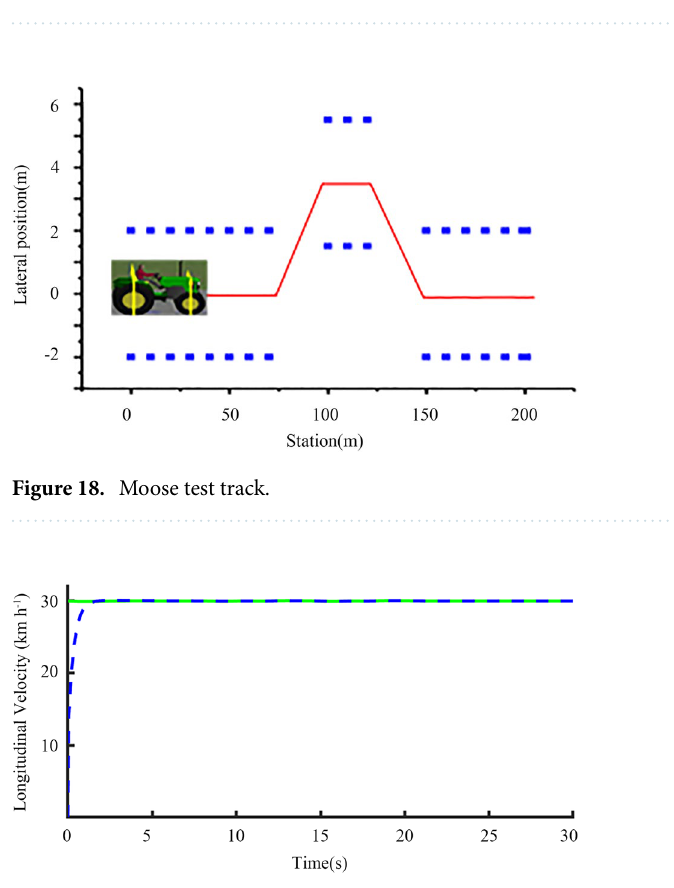
Table 2. Parameters of the tractor model.